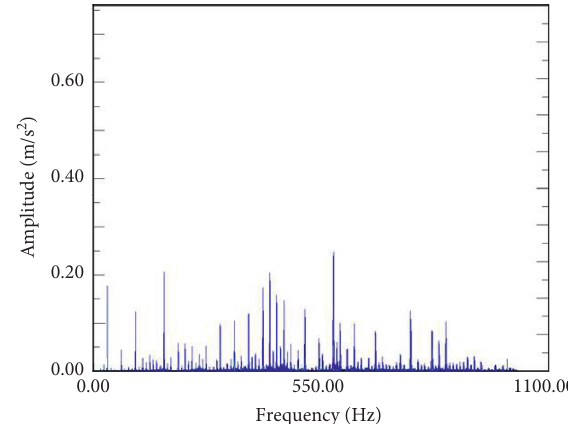
Figure 7: Experimental frequency-domain dynamic response characteristic curves of measuring point 2 in the vertical direction.